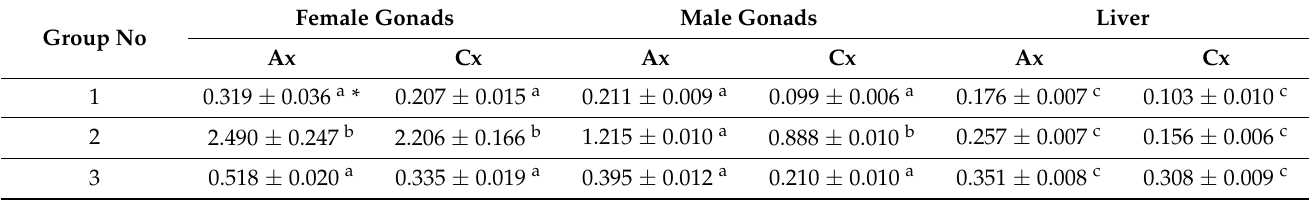
Table 2. Ax and Cx amounts in different organs of rainbow trout, O. mykiss (n = 6, mean ± SD). Female Group No